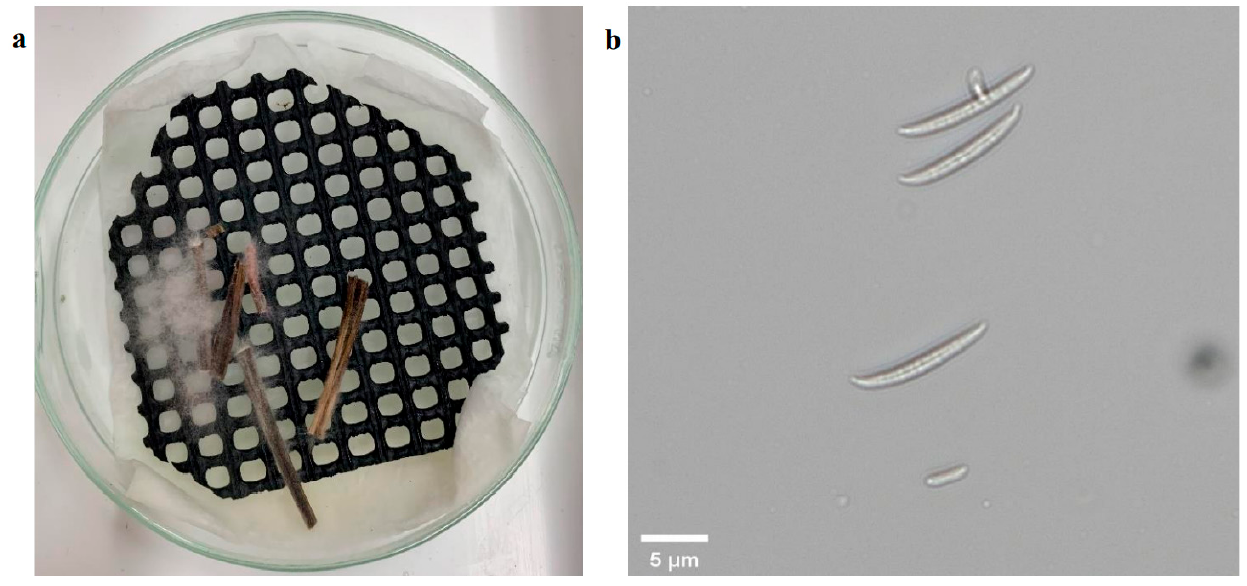
Figure 7. Pathogen isolation result. Depicts fungi cultivated on plates in the image ( a ) and fungi observed under 20 × microscope in the image ( b ).